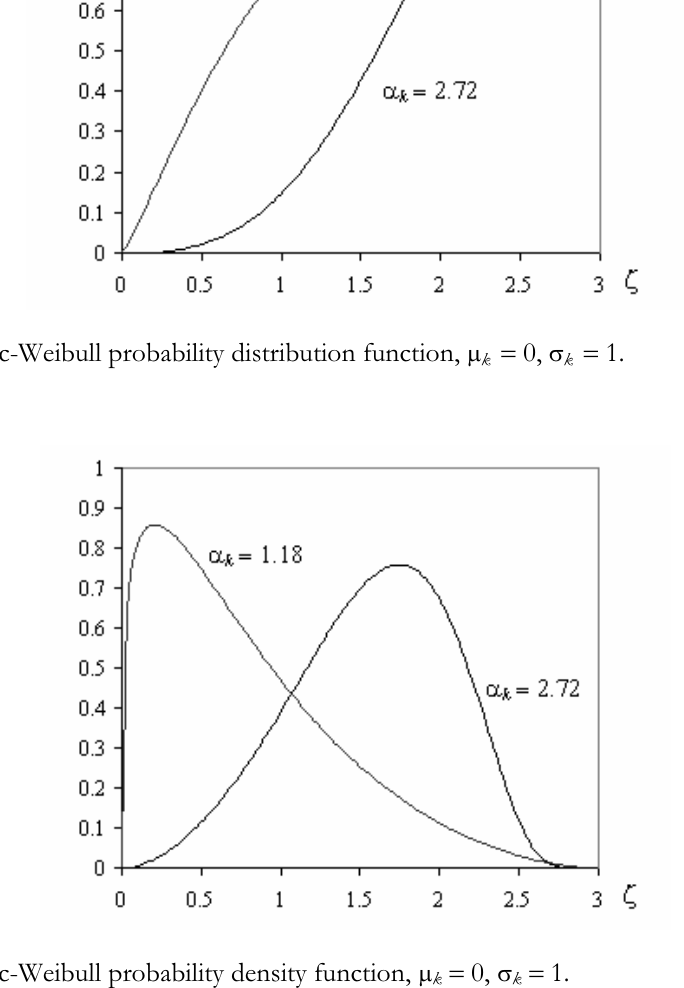
Figure 3 – Logistic-Weibull probability density function, (cid:80)